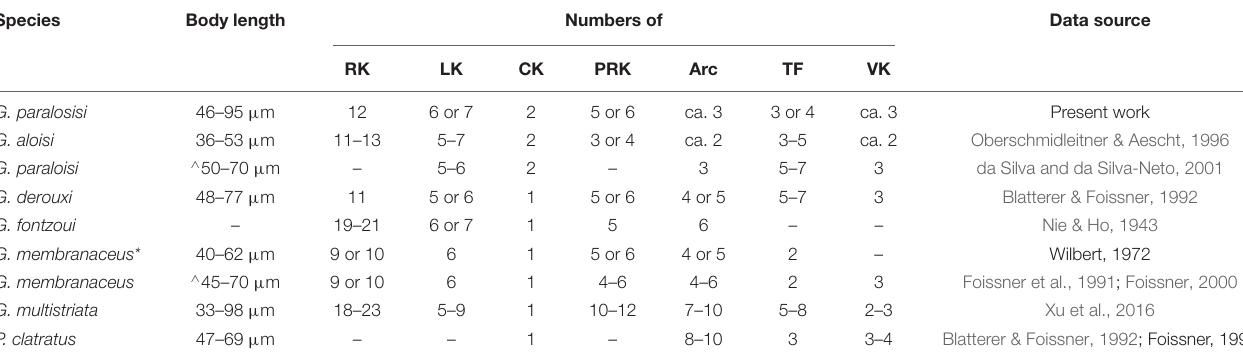
TABLE 4 | Morphometric comparison of Gastronauta and Paragastronauta species. Species Body length Numbers of Data source